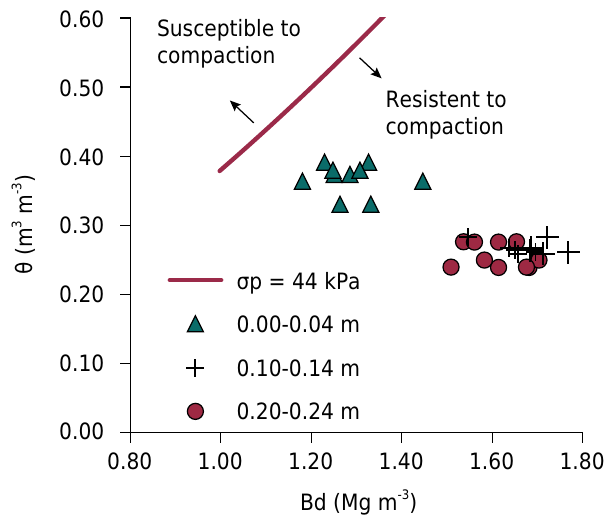
Figure 4. Combinations of bulk density (Bd) and volumetric water content (θ) that result in the preconsolidation pressure (σp) of 44 kPa (M113 BR’s static load) using the parameterized equation